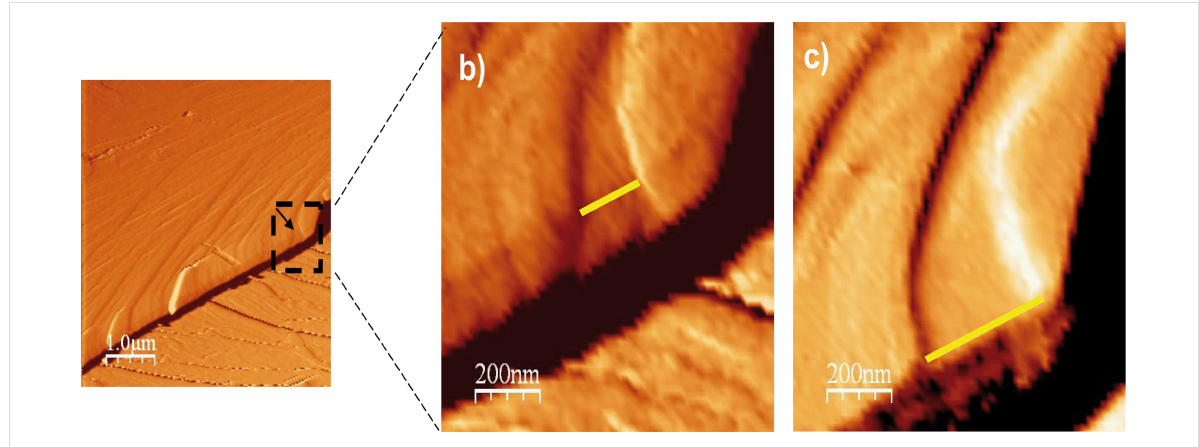
Figure 4: AFM deflection images of dolomite dissolution in Millipore MQ water: a) in air image of the dolomite (010) surface (exp. dol 1 in Table 1). Selected squared region in (a) to calculate the step-retreat rate based on the variation in length with time of the pointed terrace. The sequential images in b) and c) after 7.5 and 11.5 min respectively, show the consequent terrace evolution.